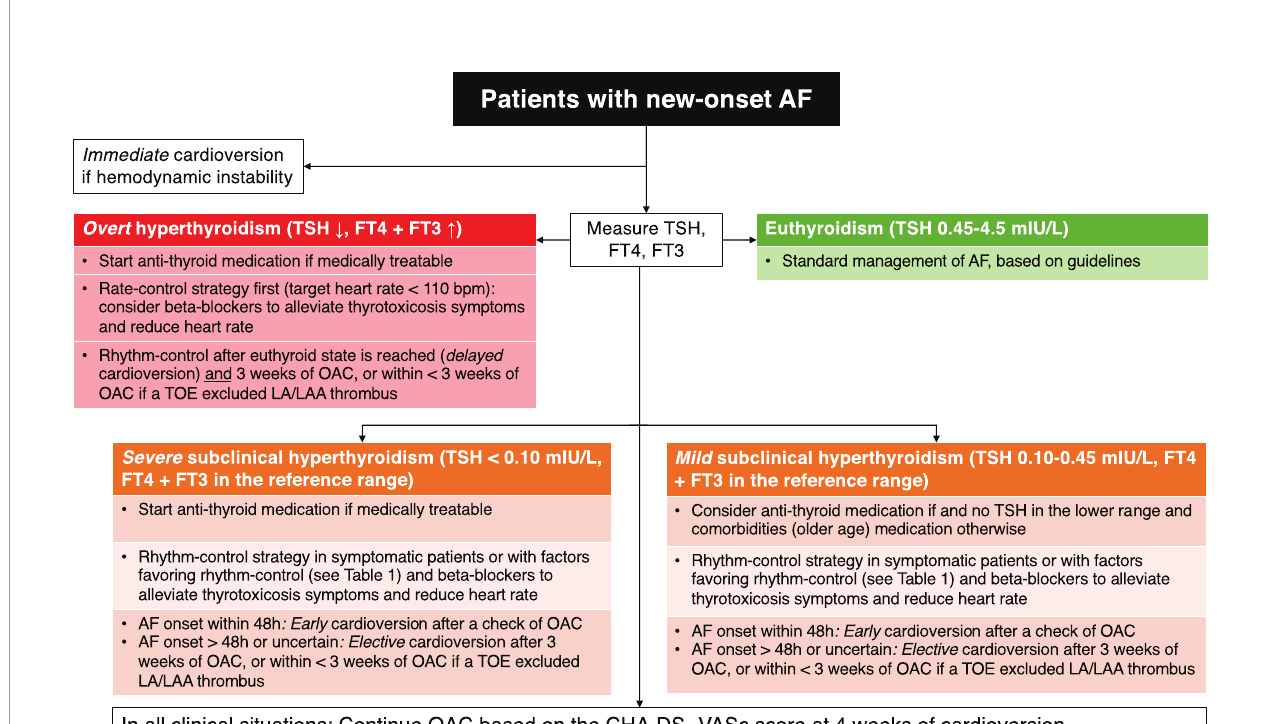
FIGURE 3 | Flowchart of clinical decision making for patients with new-onset atrial fi brillation and subclinical hyperthyroidism. AF, atrial fi brillation; FT3, free triiodothyronine; FT4, free thyroxine; LA, left atrium; LAA, left atrial appendage; OAC, oral anticoagulation; TOE, trans-esophageal echocardiography; TSH, thyroid- stimulating